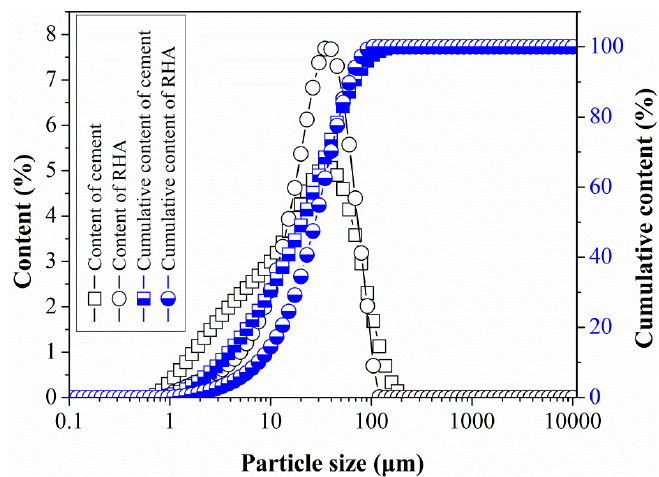
Figure 4. Particle size distribution of cement and RHA.